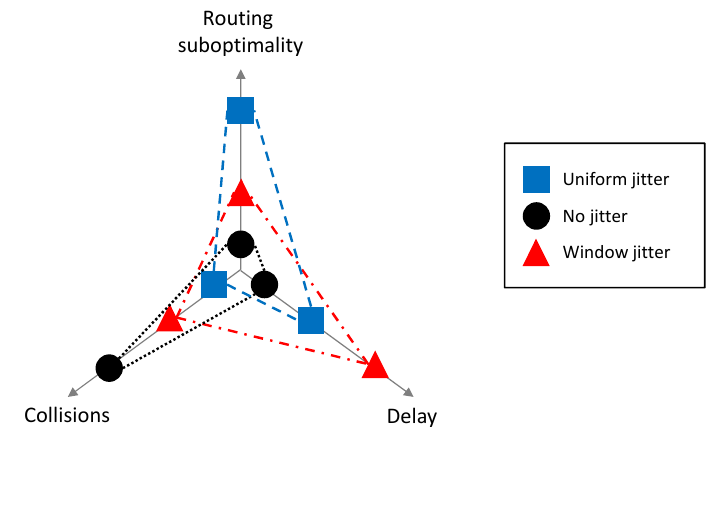
Comparative diagram between no jitter (circle), uniform or standard jitter (square) and window jitter